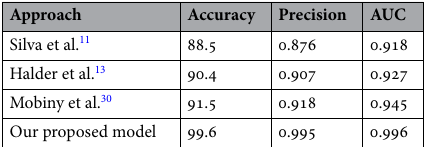
Table 6. Comparison with other methods.